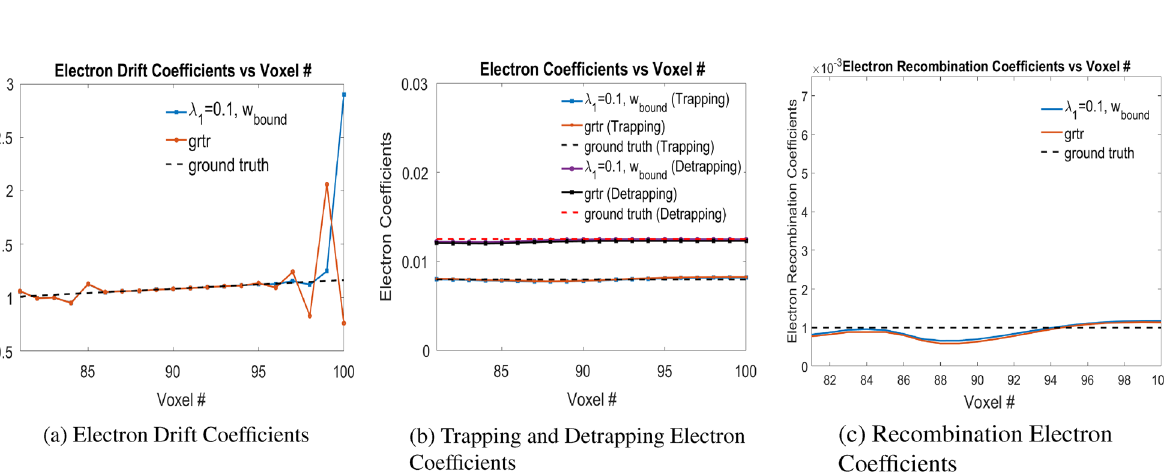
Figure 11. ( a ) Drift, ( b ) Trapping and Detrapping and, ( c ) Recombination Electron Coefficients for electron injection at Voxels 81, 84 and 87 in Physical Model-4 with (cid:31) 1 = 0.1 in Eq. (9). Readers are suggested to enlarge the figure for closer